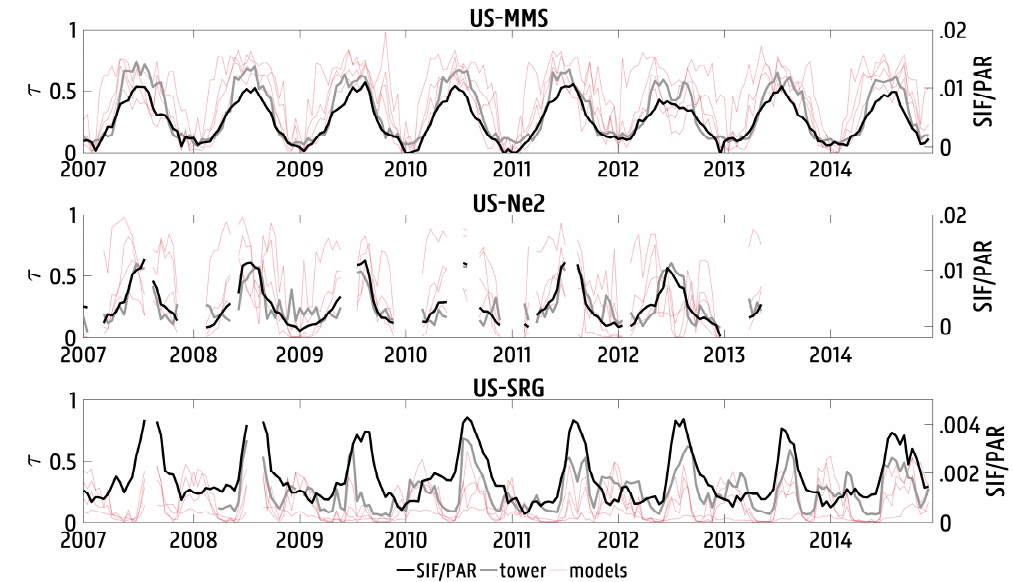
Figure 3. Timing of transpiration efficiency ( τ ). Bi-weekly times series of τ from the flux tower sites US-MMS (deciduous broadleaf forest), US-Ne2 (crop) and US-SRG (grassland) compared to SIF/PAR and the eartH2Observe models for 2007–2014. Precipitation and snow dates are masked.